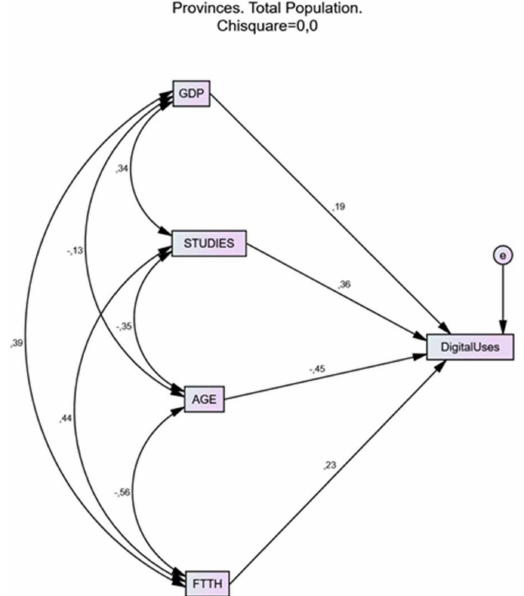
Figure 5. Differences between provinces. Total population digital